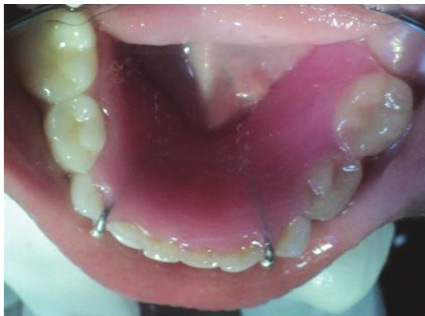
Figure 5: Postoperative intraoral view with a removable functional space maintainer.